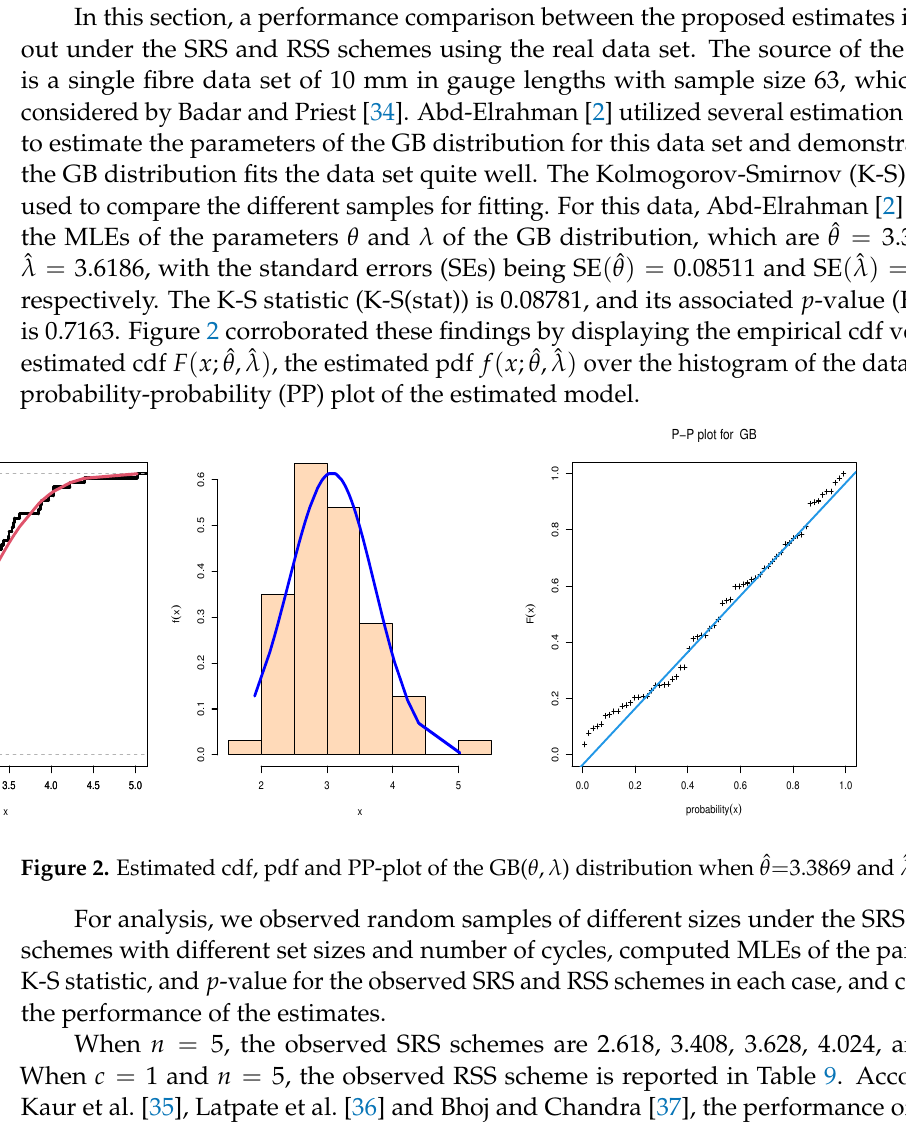
Table 9. RSS scheme from the GB( θ , λ ) distribution when c = 1 and n = 5.